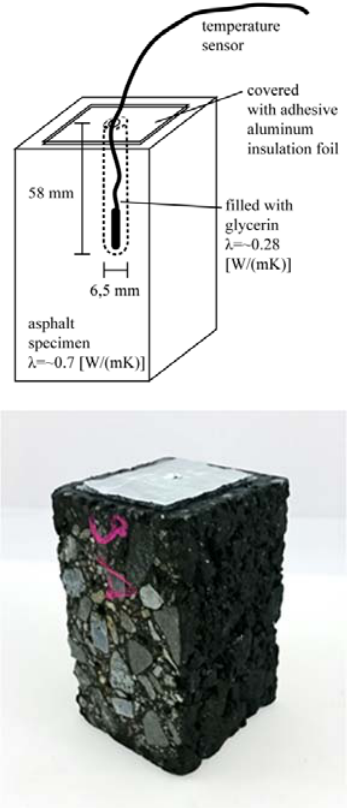
Figure 4. Schematic view and photo of a dummy